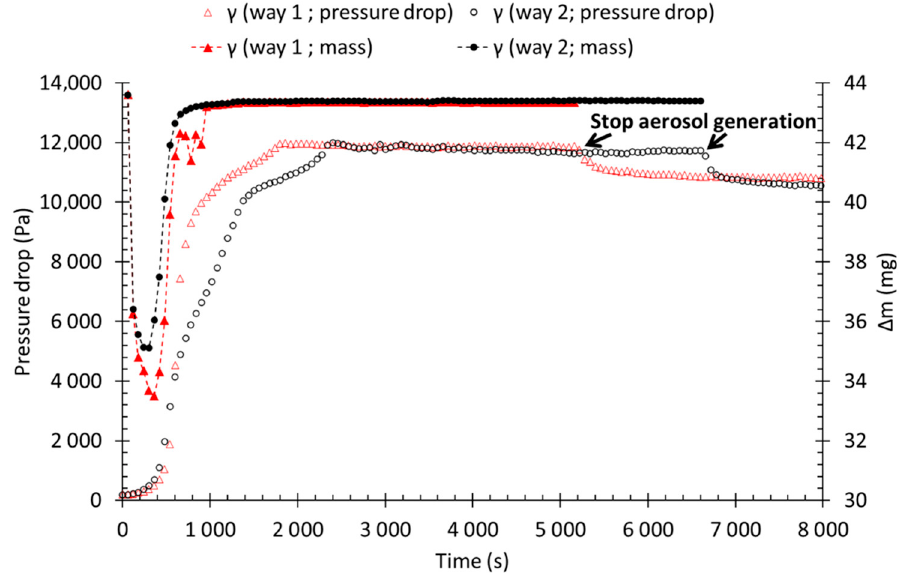
Figure 12. Pressure drop and collected mass as a function of time, for filter γ (6 cm/s). When the aerosol feeding is stopped, the pressure drop decreases in the same way as for symmetrical filters due to the loss of the liquid film downstream. For filter γ in the direction 1, stabilised pressure drop is reduced from 11,900 to 10,700 Pa (i.e., a loss of about 10% of the pressure drop at saturation). Additionally, for filter γ in the direction 2, stabilised pressure drop is reduced from 11,700 to 10,500 Pa (i.e., a loss of about 10% of the pressure drop at saturation).